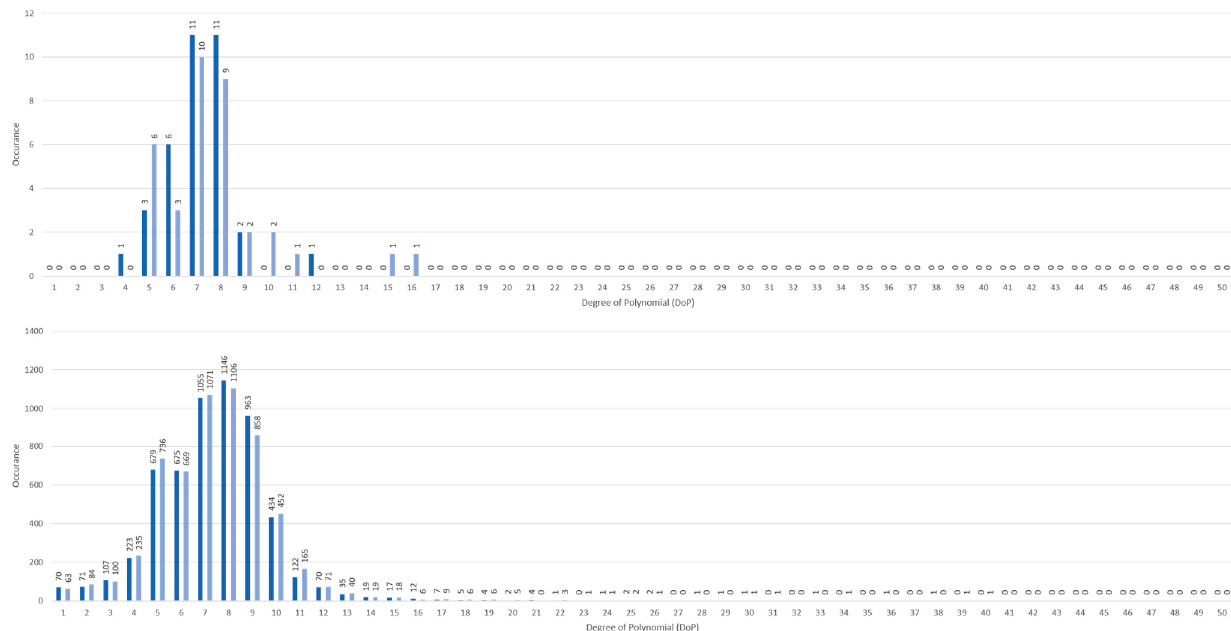
Figure 5. DoP distribution for PJ datasets ( top ) and IJ datasets ( bottom ). Only highest CVSM per dataset was registered.